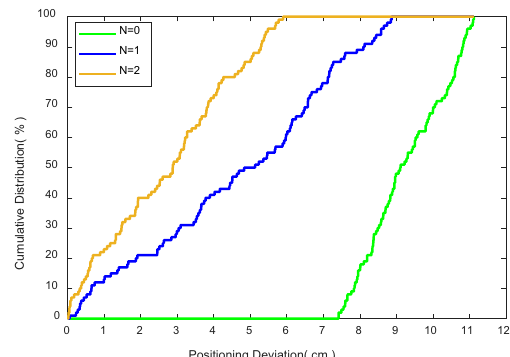
Fig. 5. The positioning accuracy if the vehicle